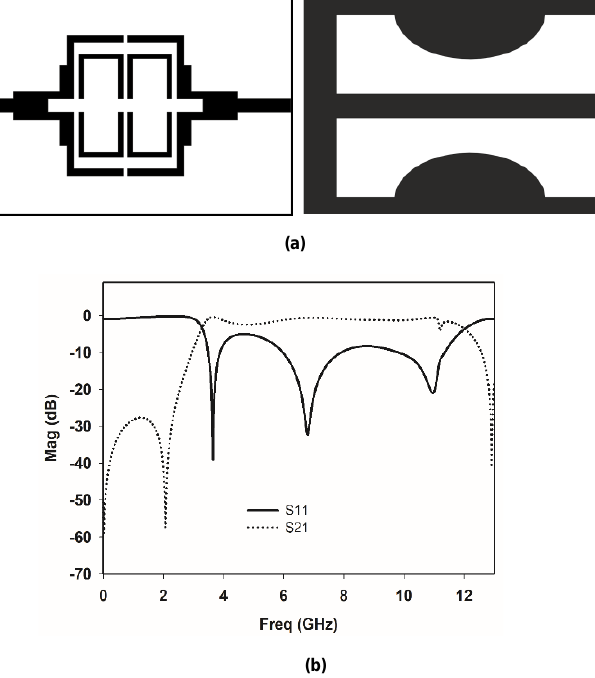
FIGURE 4. Geometry and simulation of the third filter design (a) Top and bottom view, (b)